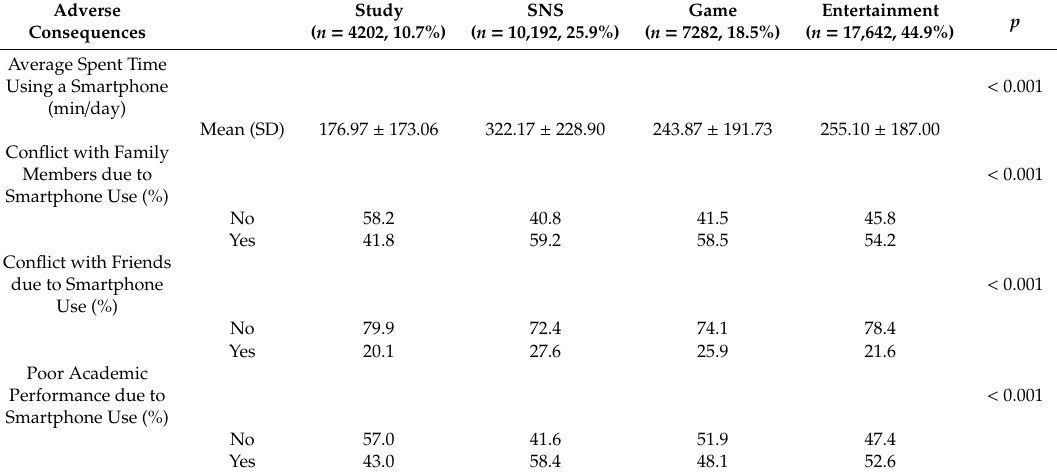
Table 3. Adverse consequences of smartphone use, according to content type of smartphone use. Adverse Consequences